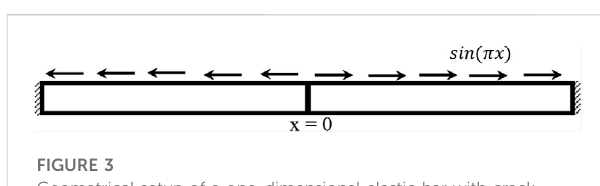
FIGURE 3 Geometrical setup of a one-dimensional elastic bar with